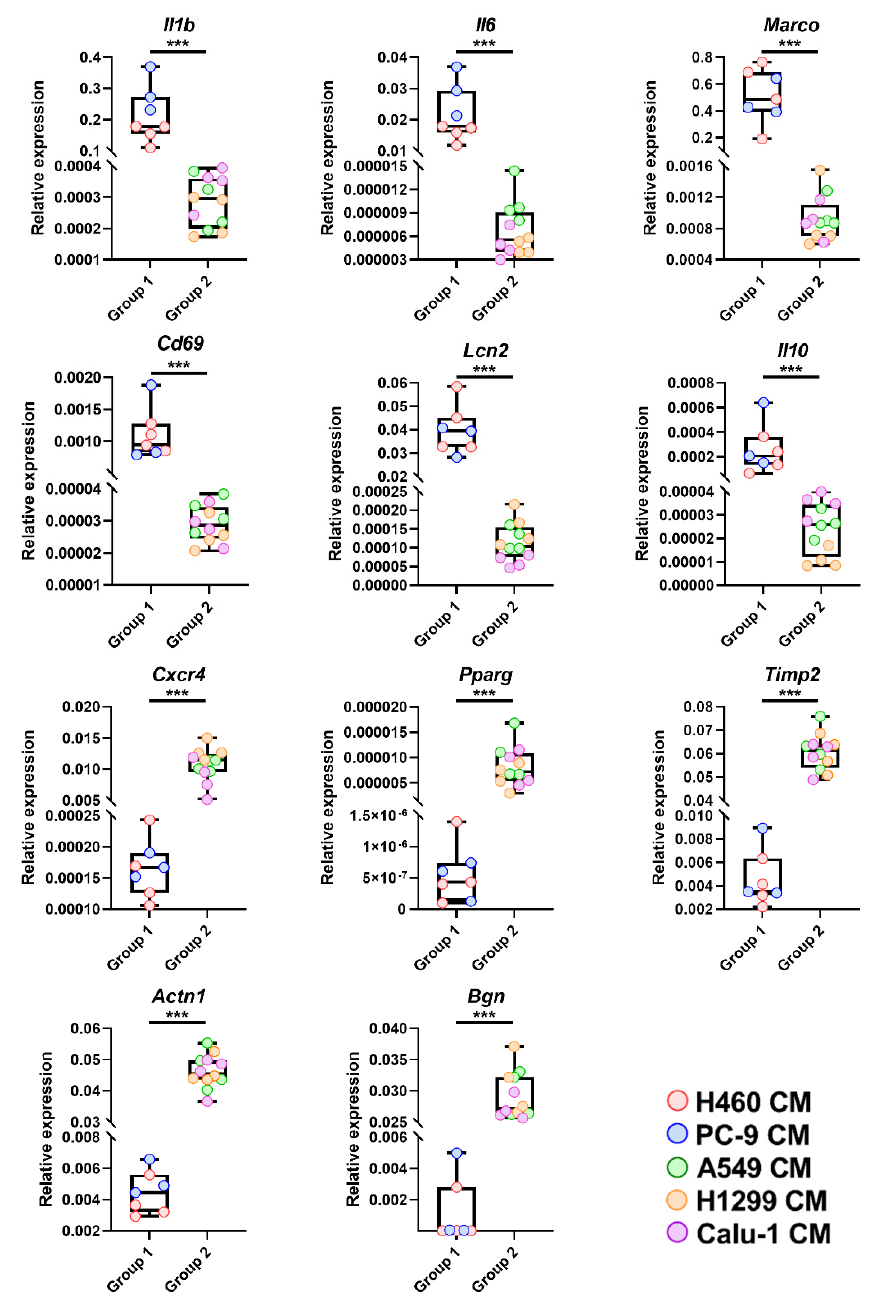
Figure 2. Validation of gene expression profile data by real-time PCR. mRNA level of Il1 β , Il6 , Marco , Cd69 , Lcn2 , Il10 , Cxcr4 , Pparg , Timp2 , Actin1 and Bgn , selected from the first quartile of the most up- ( Il1 β , Il6 , Marco , Cd69 , Lcn2 , Il10 ) or down- ( Cxcr4 , Pparg , Timp2 , Actin1 , Bgn ) regulated genes between Group 1 and Group 2 BMDMs (FDR < 0.01), was analyzed by real-time PCR. Results are presented as 2 − ∆ Ct . *** p < 0.001 by two-tailed unpaired Student’s t -test or the Mann–Whitney U test for nonparametric distribution of data.